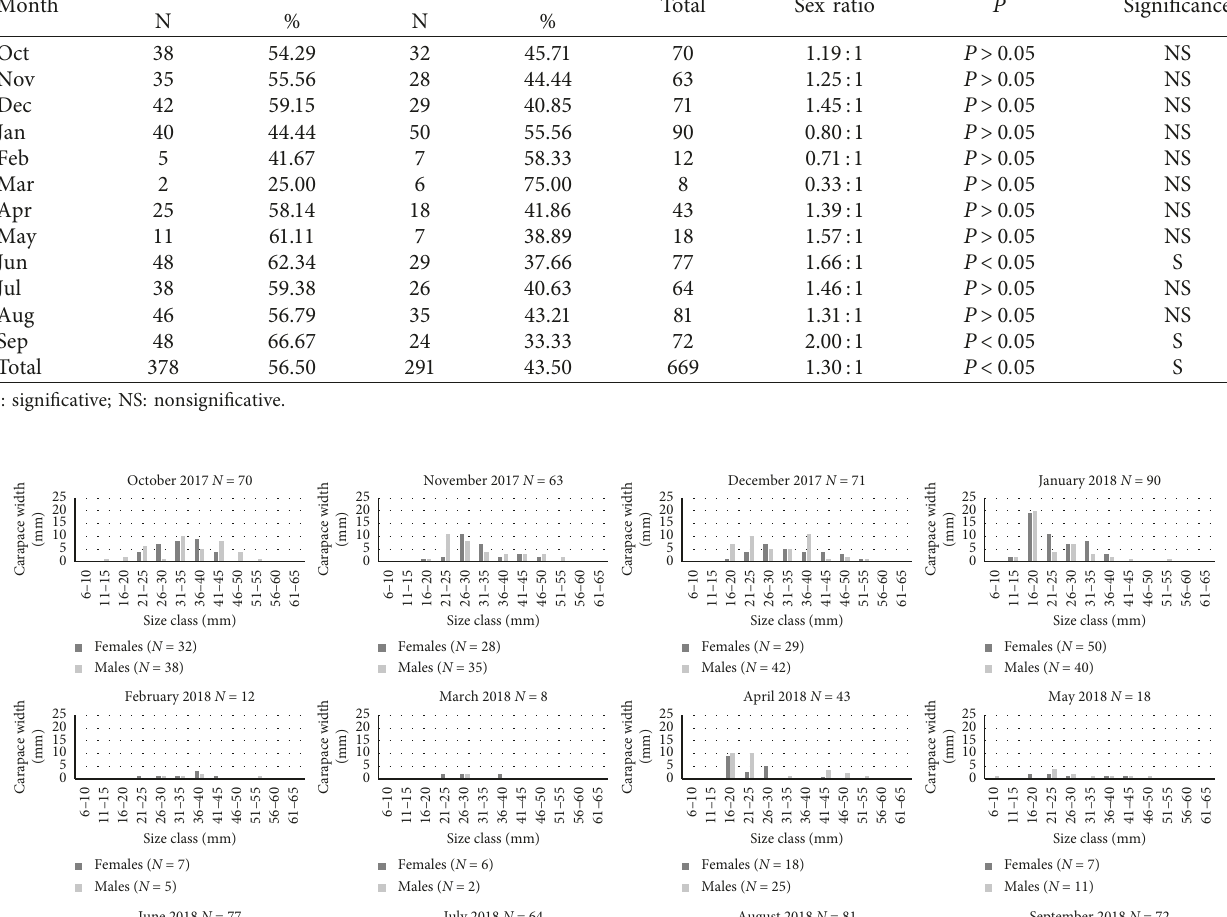
Table 2: Sex ratio by month of Potamon algeriense from Oued Zegzel, Morocco, over one year period ( P < 0 . 05). Males Females